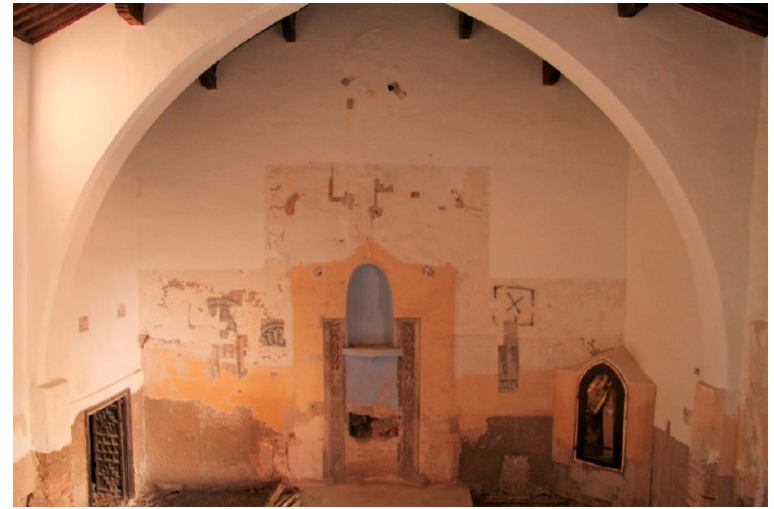
Figure 2. The Synagogue of Híjar. Photo by Antonio Hernández Pardo. Used by permission.